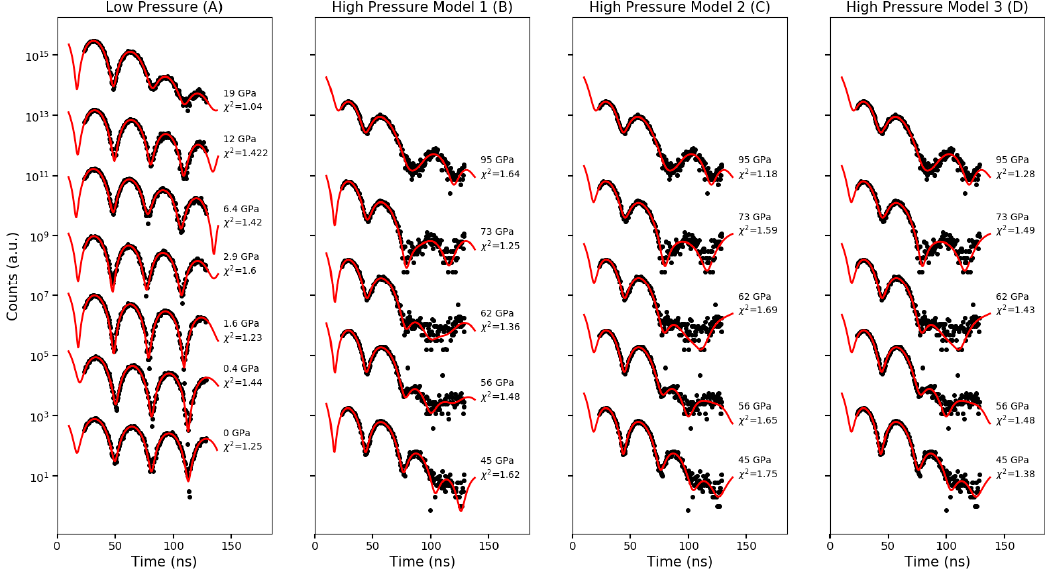
Figure 3. Representative synchrotron Mössbauer spectroscopy (SMS) spectra of szomolnokite: black circles are binned data and red curves are best fit results from CONUSS. ( A ) All models are identical from 0 to 19 GPa. ( B ) Model 1 features only 3 sites and assumes all the iron in the material remains in the high-spin state up to 95 GPa. ( C ) Model 2 applied to 19 to 95 GPa. This features an additional site, which could indicate a transition (increased distortion, structural, or high- to low-spin transition) that occurs between 19 and 45 GPa. ( D ) Model 3 applied to the higher pressures. This model features a gradual increase in presence of a low spin site from 19 to 95 GPa.